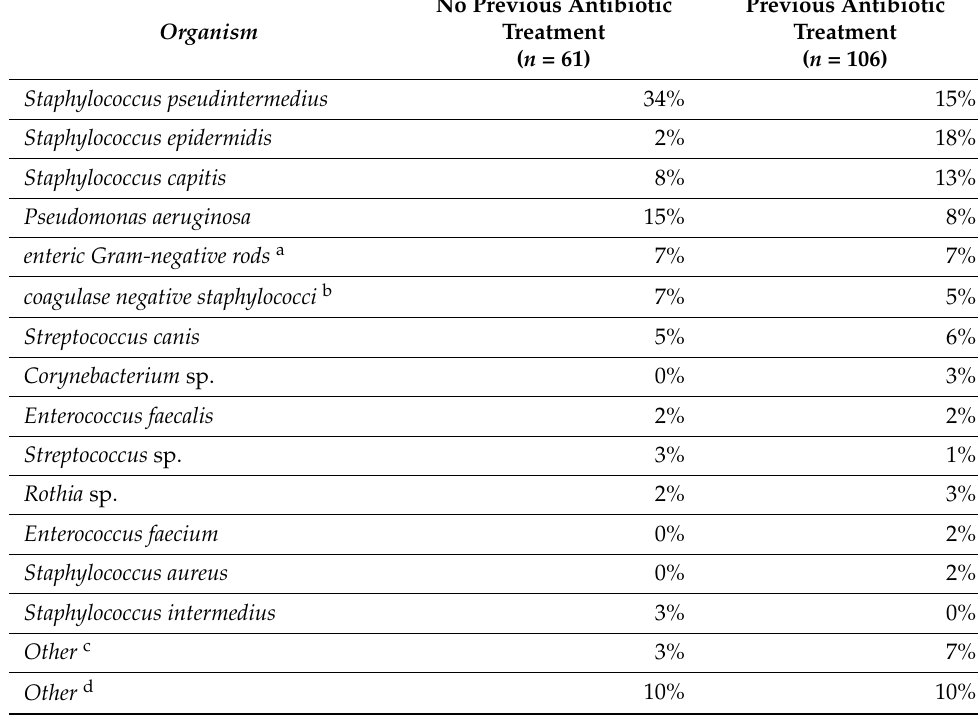
Table 3. Bacterial species distribution from corneal stromal ulcer samples relative to the patient’s previous antibiotic treatments. Distribution of isolates in canine patients. Data are presented as a percentage of total isolates ( n = 61 and n = 106). a Citrobacter freundii, Enterobacter cloacae, Escherichia coli , and Serratia marcescens ; b Staphylococcus spp. ( S. auricularis , S. hominis , S. saprophyticus , S. simulans , S. warneri , and S. xylosus ) excluding S. pseudintermedius , S. capitis , S. epidermidis ,